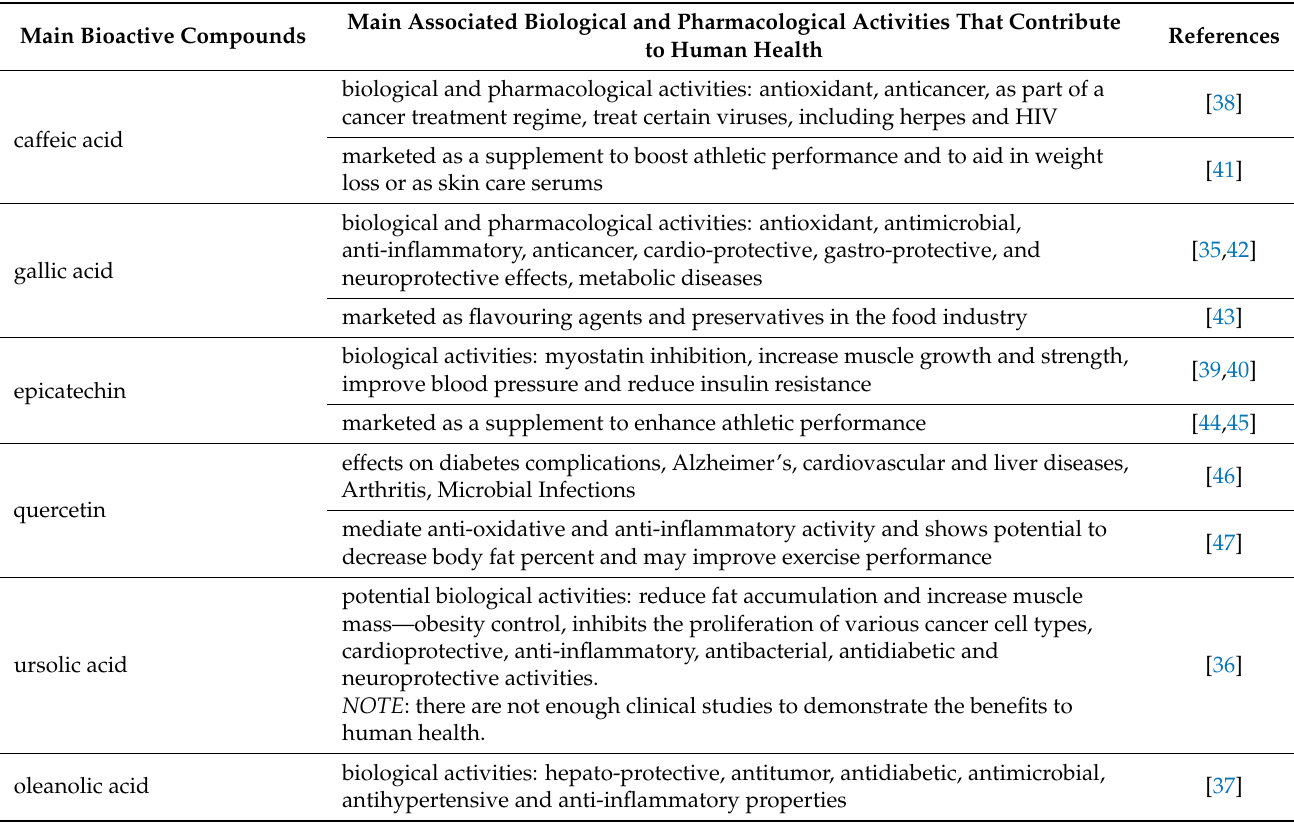
Table 4. The main bioactive compounds identified in the studied apple cultivars and the associated biological and pharmacological activities which contribute to human health (according to the literature). Main Bioactive